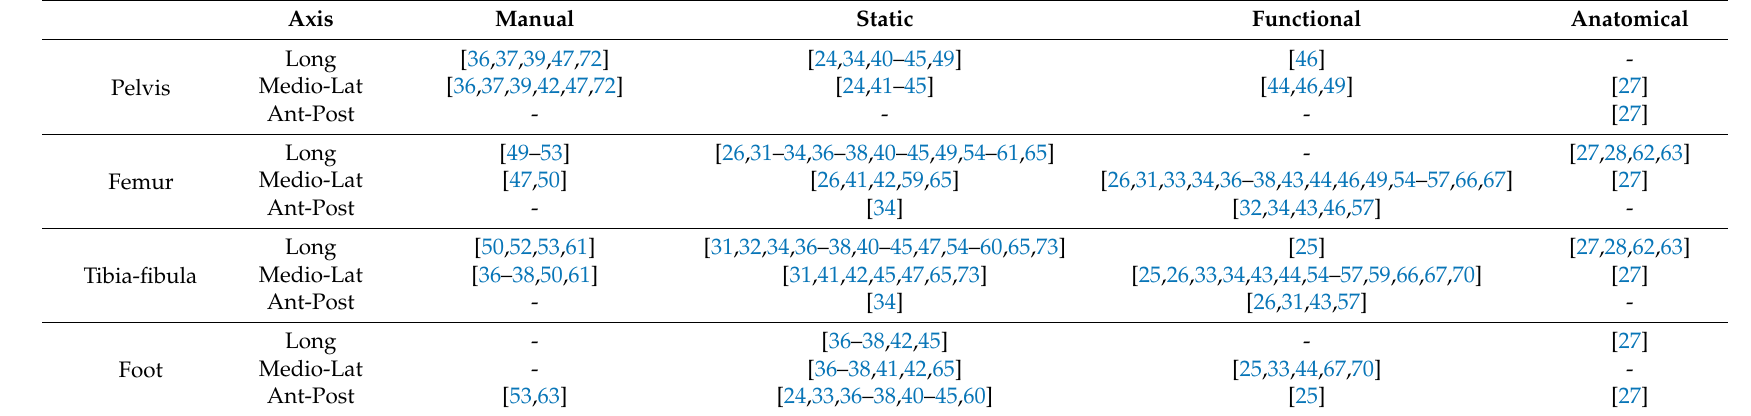
Table 1. Calibration approach used by the studies presented for each segment